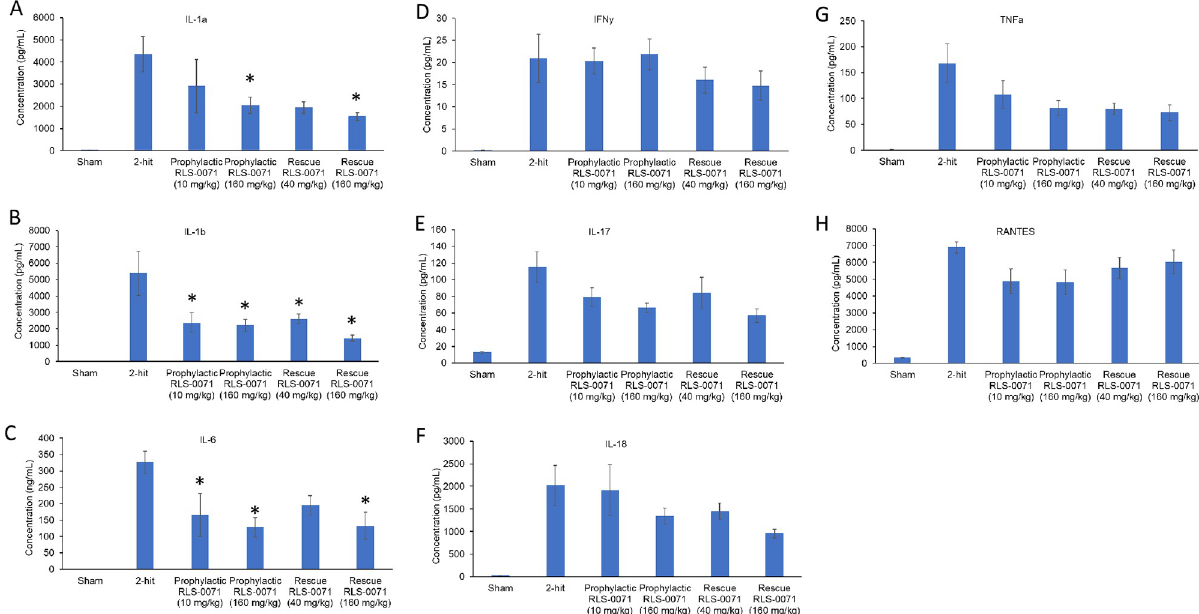
Fig 6. RLS-0071 reduces levels of inflammatory cytokines in the blood. Cytokine levels (A) IL-1a, (B) IL-1b, (C) IL-6, (D) IFN-g, (E) IL-17, (F) IL-18, (G) TNFa and (H) RANTES from terminal blood draws were determined by xMAP bead based immunoassay for the following experimental groups: sham, 2-hit, 2-hit + 10mg/kg prophylactic dose RLS-0071, 2-hit + 160mg/kg prophylactic dose RLS-0071 as well as 2-hit + 40mg/kg rescue dose RLS- 0071 and 2-hit + 160mg/kg rescue dose RLS-0071. For sake of clarity only rescue dosing data is shown. Data are means and standard error of the mean. � denotes P < 0.05 compared to animals receiving the 2 hit